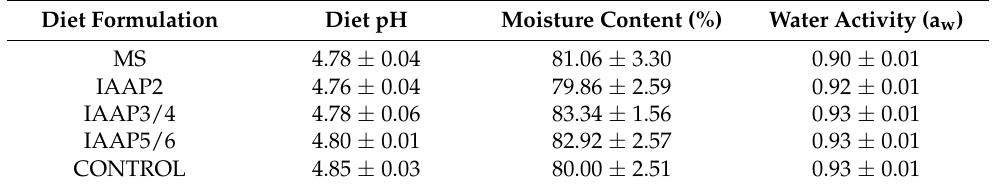
Table 2. Mean ( ± SE) pH, moisture content and water activity of the MS, IAAP2, IAAP3/4, IAAP5/6 and control diets from the period of inoculation to harvest (4-week testing period).